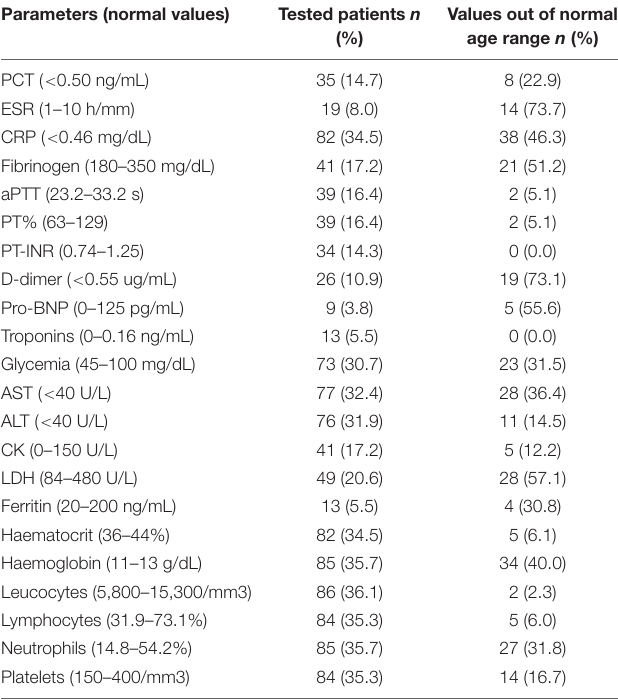
Parameters (normal